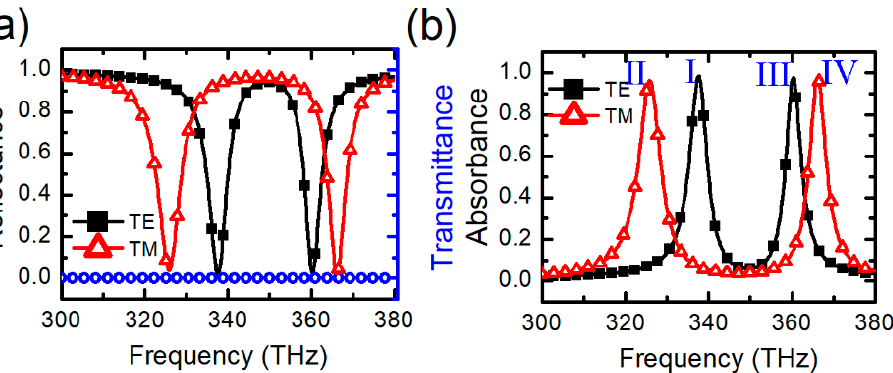
Figure 2. ( a ) Simulated reflectance and transmittance curves for TE- and TM-polarized waves illuminate on elliptical metamaterial, respectively. ( b ) The corresponding absorbance of TE- and TM-polarized waves.